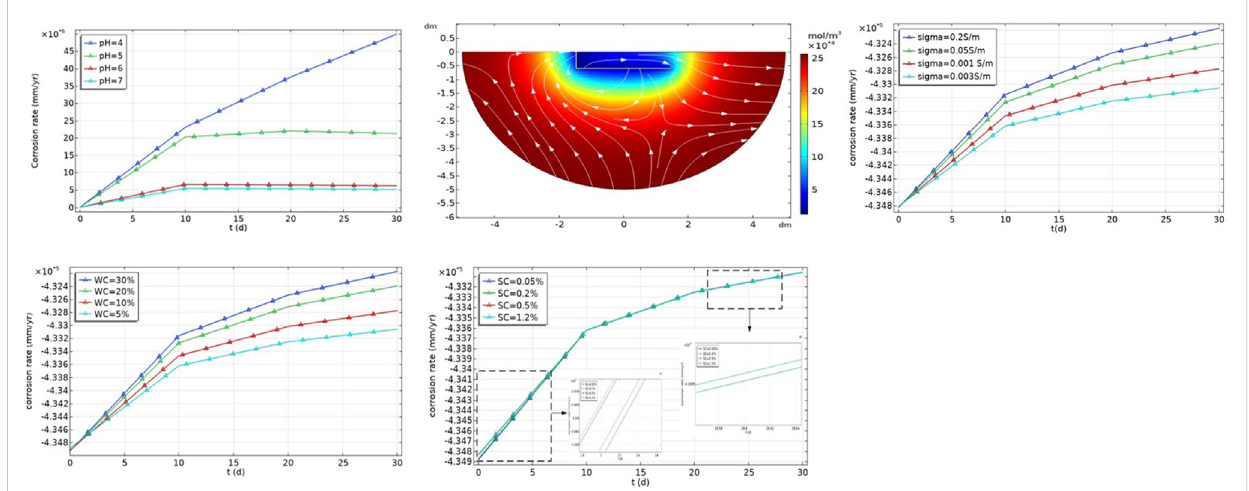
FIGURE 7 Therelationship betweenin fl uencing factors andcorrosionrate: (A) Effect ofPHvalueon corrosion rate; (B) Hydrogen concentrationafter 30 days; (C) Effect of water content on corrosion rate; (D) Effect of salt content on corrosion rate; (E) Effect of soil resistivity on corrosion rate.